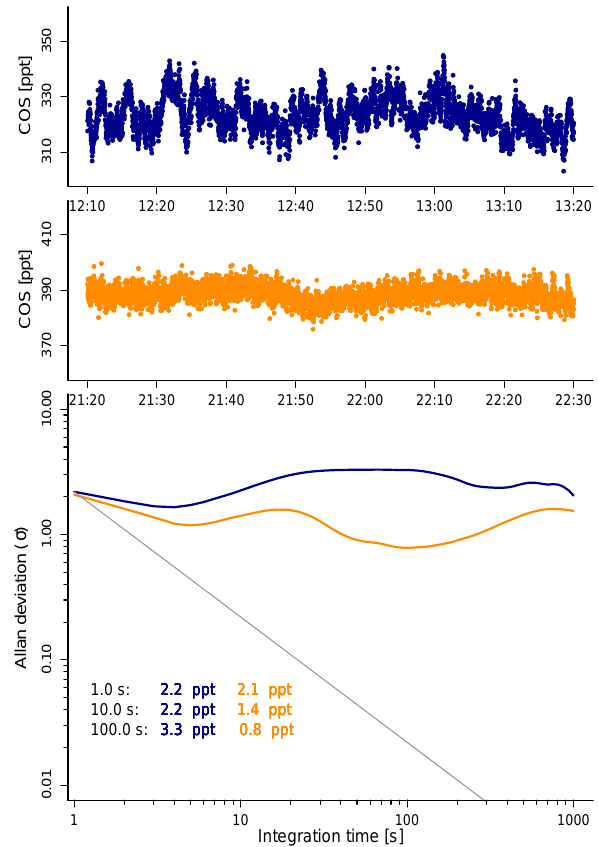
Figure 7. Two Allan deviation plots of COS retrieved from cylinder air measurements during two laboratory experiments under similar conditions on the same day. The Allan deviation plots show that the lowest random noise level of drift is not constant over